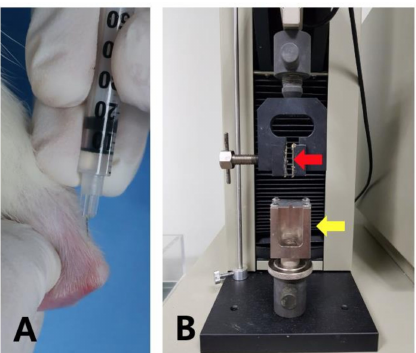
Figure 6. Injection in the Achilles tendon, treadmill running, biomechanical test machine. Using a 27-G needle, phosphate-buffered saline or substance P (SP) was injected to the insertion of the Achilles tendon. To make the needle direction parallel to the long axis of the Achilles tendon, the needle was bent before injection. After the Achilles tendon was fully stretched through knee extension and ankle dorsiflexion, the needle was introduced distally from the musculotendinous junction ( A ). A biomechanical test machine was used to measure the tensile strength of the muscle-tendon-bone complex. Red and yellow arrows indicate sample holders for the musculotendinous junction and bone tendon complex, respectively ( B